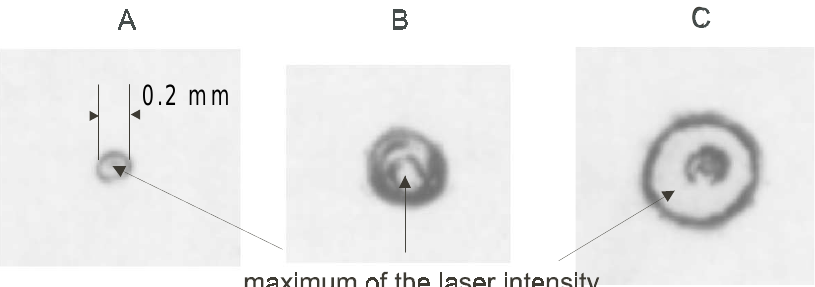
FIG. 7. Burn patterns made with the CO 2 laser beam on the thermal paper placed at the focal plane (image A) and at the distance 3.5 mm (image B) and 7 mm (image C) from the focus. Images are obtained at different attenuations of the laser beam. Marked white areas correspond to the strongest burn (white ash) surrounded by the areas of a less thermal exposure (black coal).